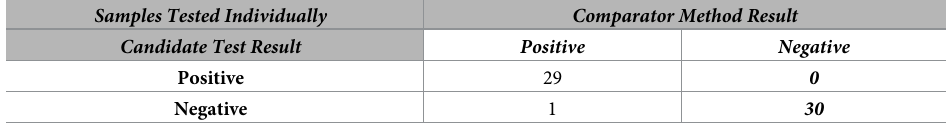
(samples collected on asymptomatic